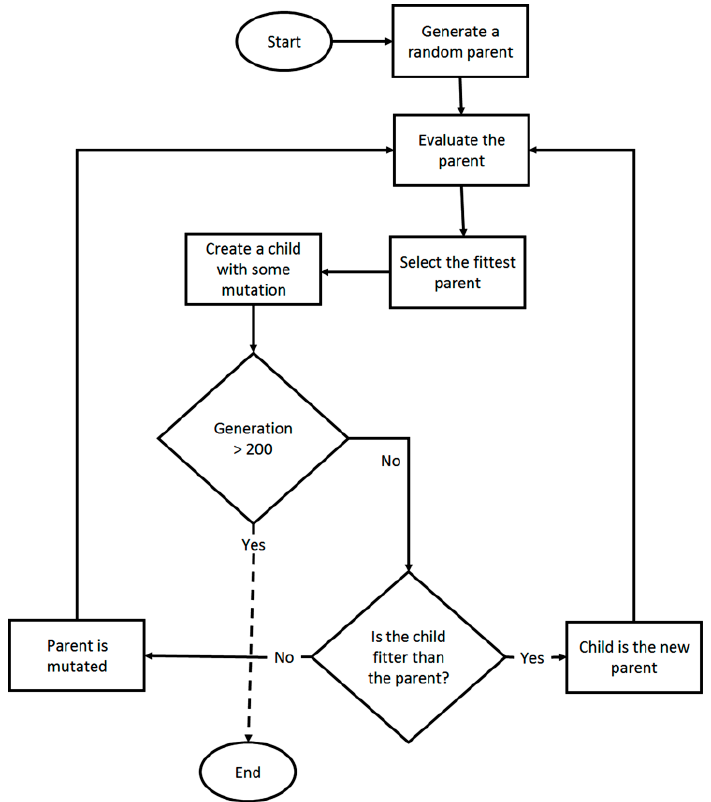
Figure 4. Flowchart of the algorithm used in this paper.